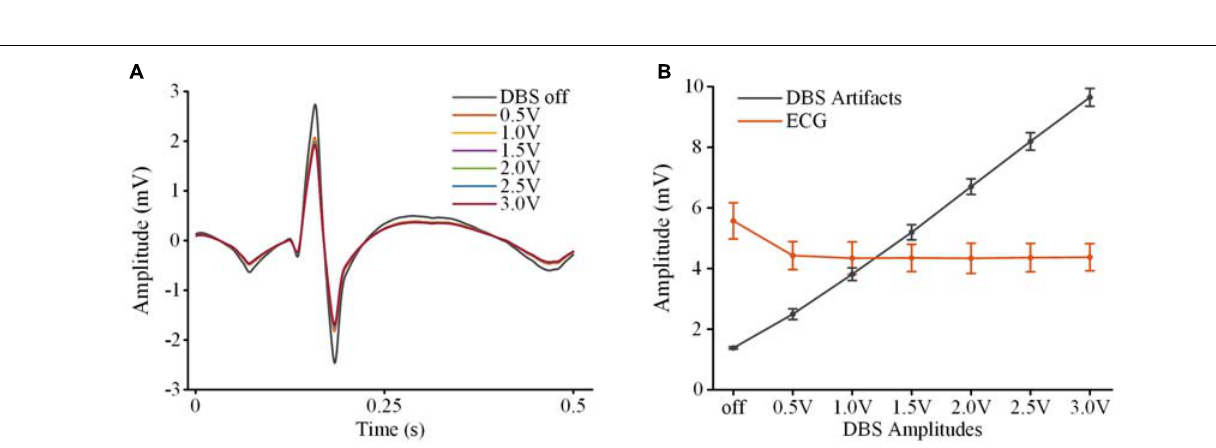
between the amplitudes of the ECG spikes ( p > 0.064, N = 266). The results indicated that by using a simple fixed 100 Hz low- pass filter, ECG spikes could be extracted from the monopolar